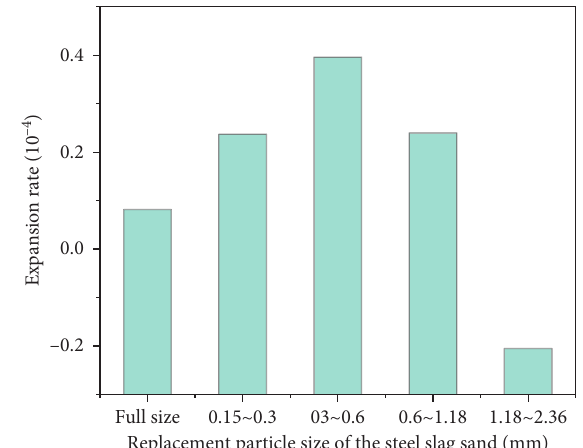
Figure 15: The impact of the water-cement ratio on the expansion rate of the FSSAC.